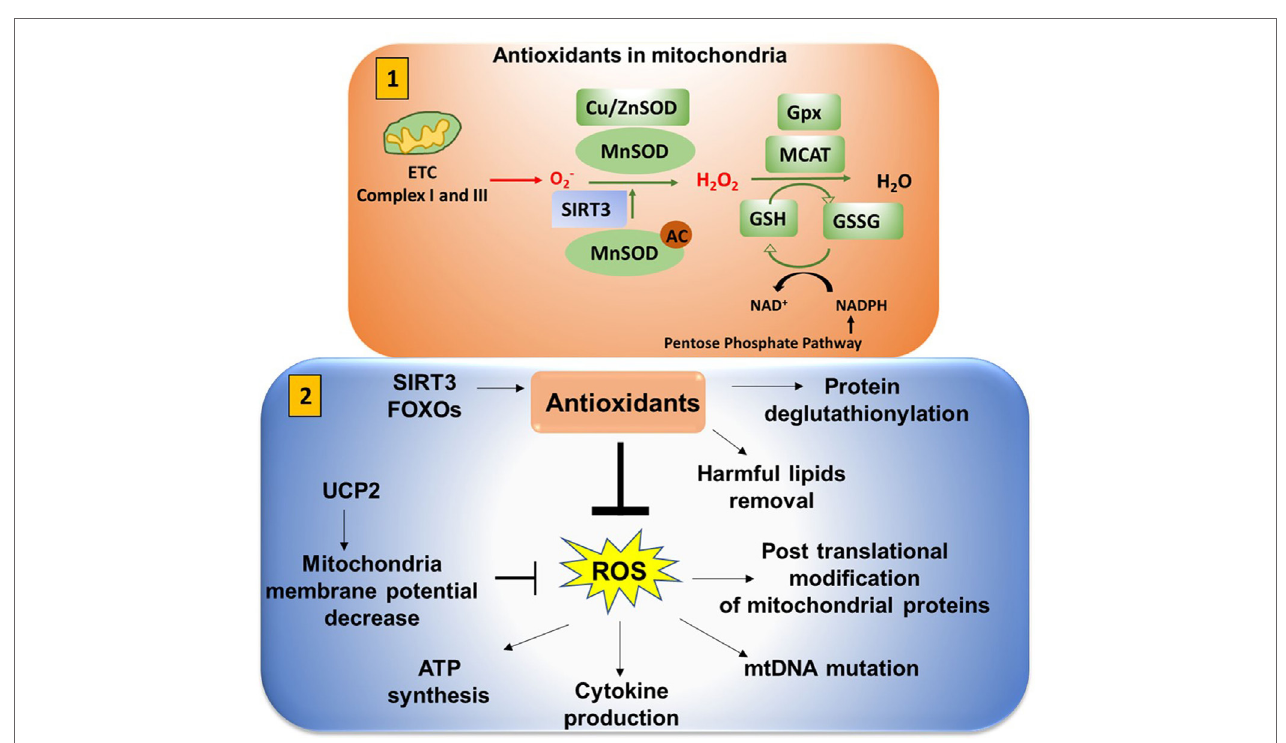
FiguRe 9 | Antioxidants neutralize mitochondrial ROS (mtROS). (1) Antioxidants in mitochondria: superoxide O 2 − ( ) is released from complex I (into the matrix) and III (into both the matrix and intermembrane space). This is converted to H 2 O 2 in the presence of superoxide dismutase (SOD). Mn-SOD (manganese dismutase) is localized in mitochondria matrix and Cu/Zn-SOD (in the intermembrane space and cytosol). SIRT3 is involved in deacetylation of MnSOD. Catalase converts H 2 O 2 to H 2 O. Catalase is also localized in mitochondria (MCAT). Glutathione converts OH − to H 2 O to reduce the cellular damage. Glutathione (GSH) is oxidized and reduced to glutathione disulfide (GSSG) in a reversible reaction. NADPH from the pentose phosphate pathway reduces GSSG to form GSH in presence of glutathione peroxidase (Gpx). (2) Antioxidants play an important role in neutralizing mtROS. Uncoupling protein 2 (UCP2) (mitochondrial uncoupler protein), which helps to shuttle H + ions from the intermembrane space to the mitochondria matrix, decreases the membrane potential to inhibit excessive reactive oxygen species (ROS) production. Excessive ROS production can impact ATP synthesis, cytokine production, mitochondrial DNA (mtDNA) mutation, and post-translational modification of cellular proteins by S-nitosylation or